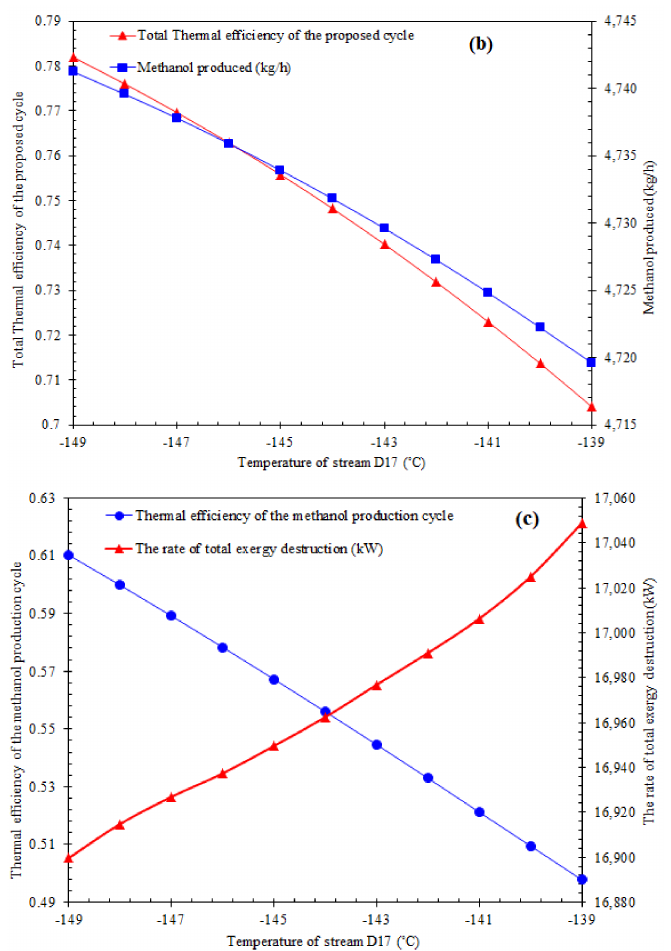
Figure 10. The influence of changes in stream D17’s temperature on principal output parameters: ( a ) The influence of changes in stream D17’s temperature on heat supplied by parabolic solar troughs and heat produced by the methanol reactor; ( b ) The influence of changes in stream D17’s temper- ature on total thermal efficiency and the methanol production rate; ( c ) The influence of changes in stream D17’s temperature on the thermal efficiency of the methanol production cycle and total exergy destruction.